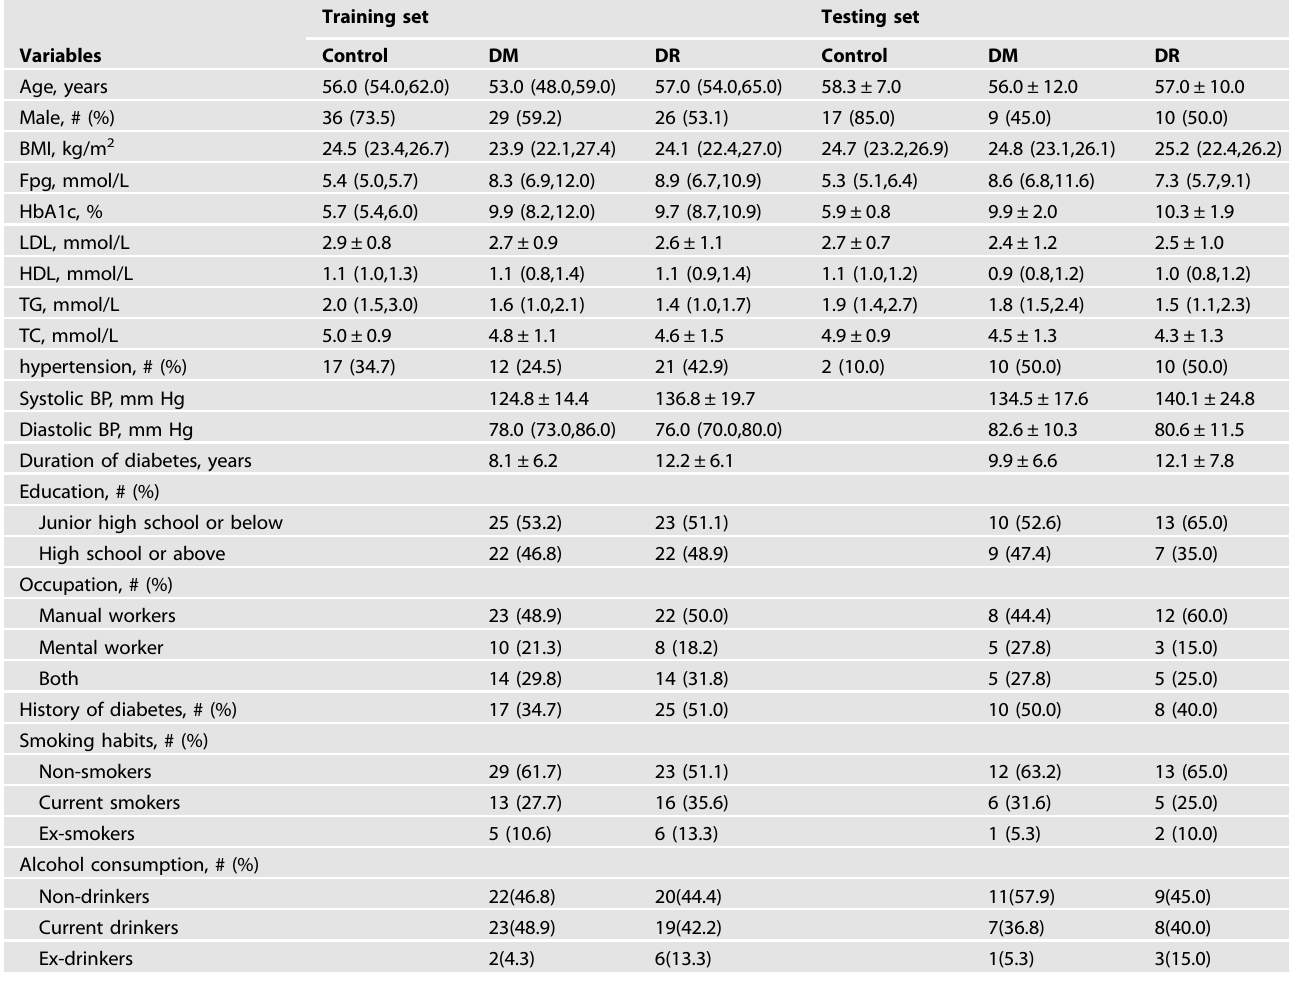
Table 1. Clinical and demographic characteristics of the study